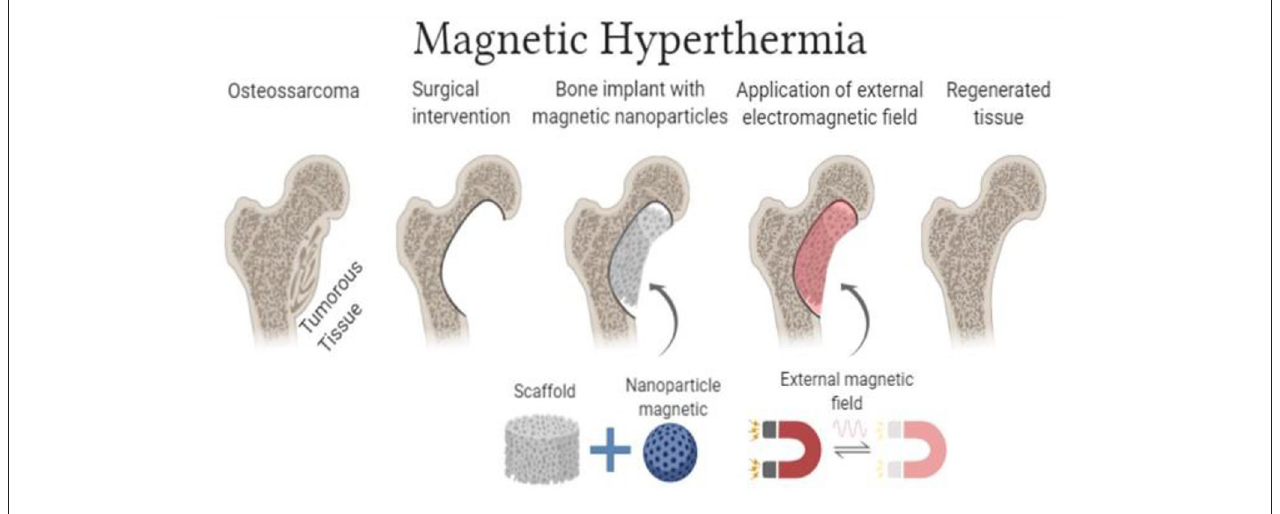
FIGURE 2 | Schematic illustration of the functioning of MH scaffolds (Image Source: created using BioRender).